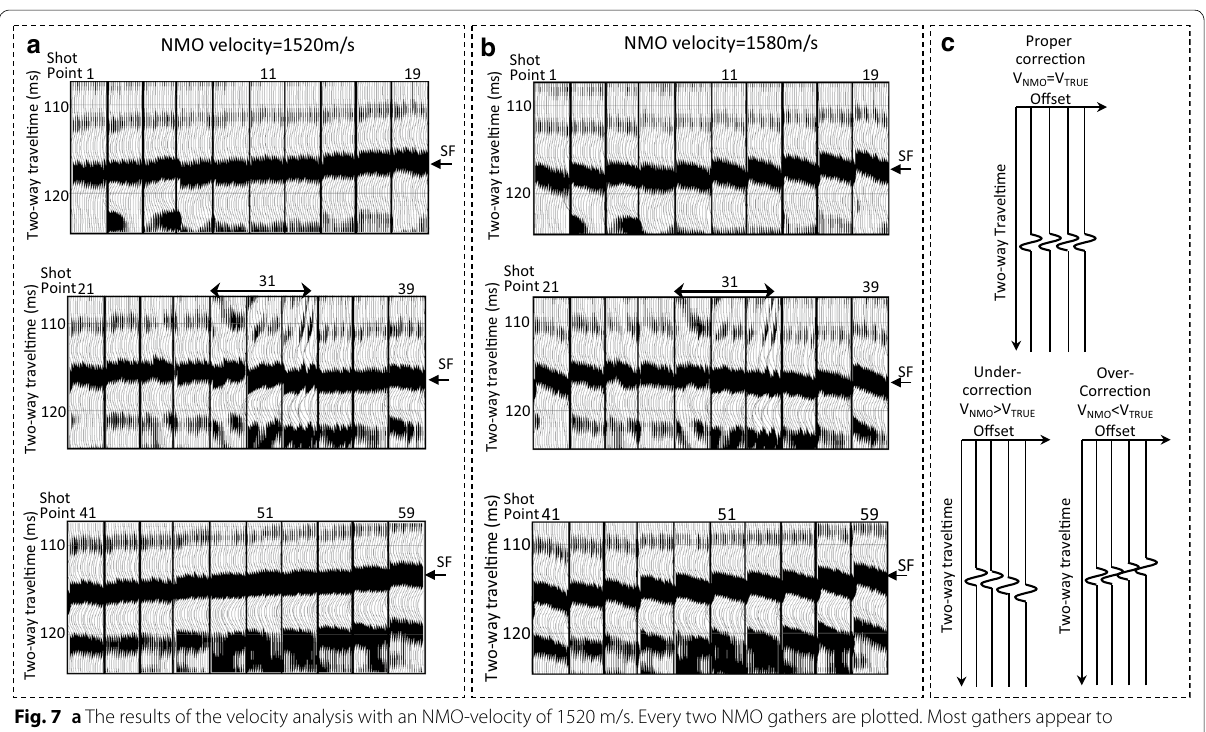
Fig. 7 a The results of the velocity analysis with an NMO‑velocity of 1520 m/s. Every two NMO gathers are plotted. Most gathers appear to be appropriately corrected, with a few exceptions of shot points 29–33. SF represents seafloor. b The results of the velocity analysis with an NMO‑velocity of 1580 m/s. Every two NMO gathers are plotted. The NMO gathers of shot points 29–33 are appropriately corrected, meaning that the true velocity is 1580 m/s. SF represents the seafloor. c Conceptual diagrams of NMO corrections with true, lower, and higher velocities are